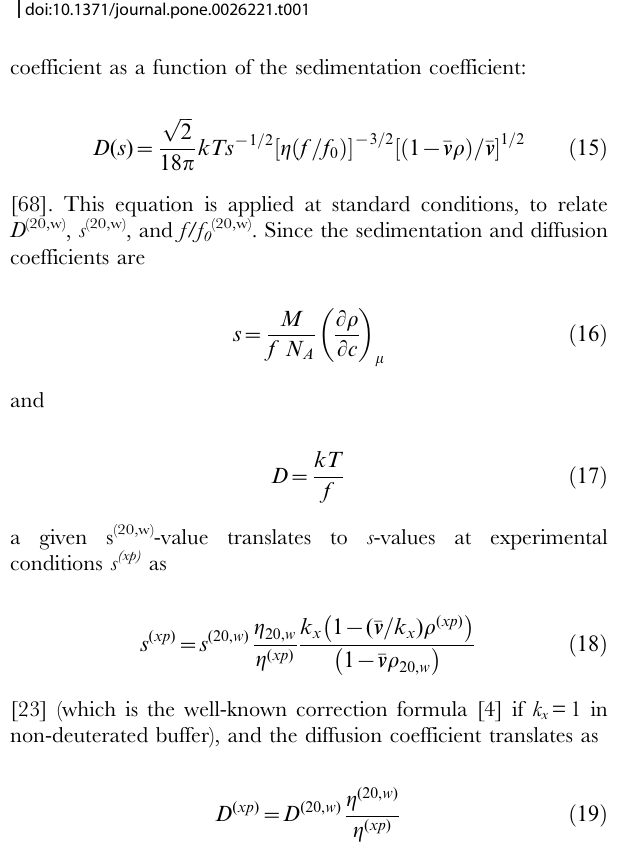
coefficient as a function of the sedimentation coefficient: